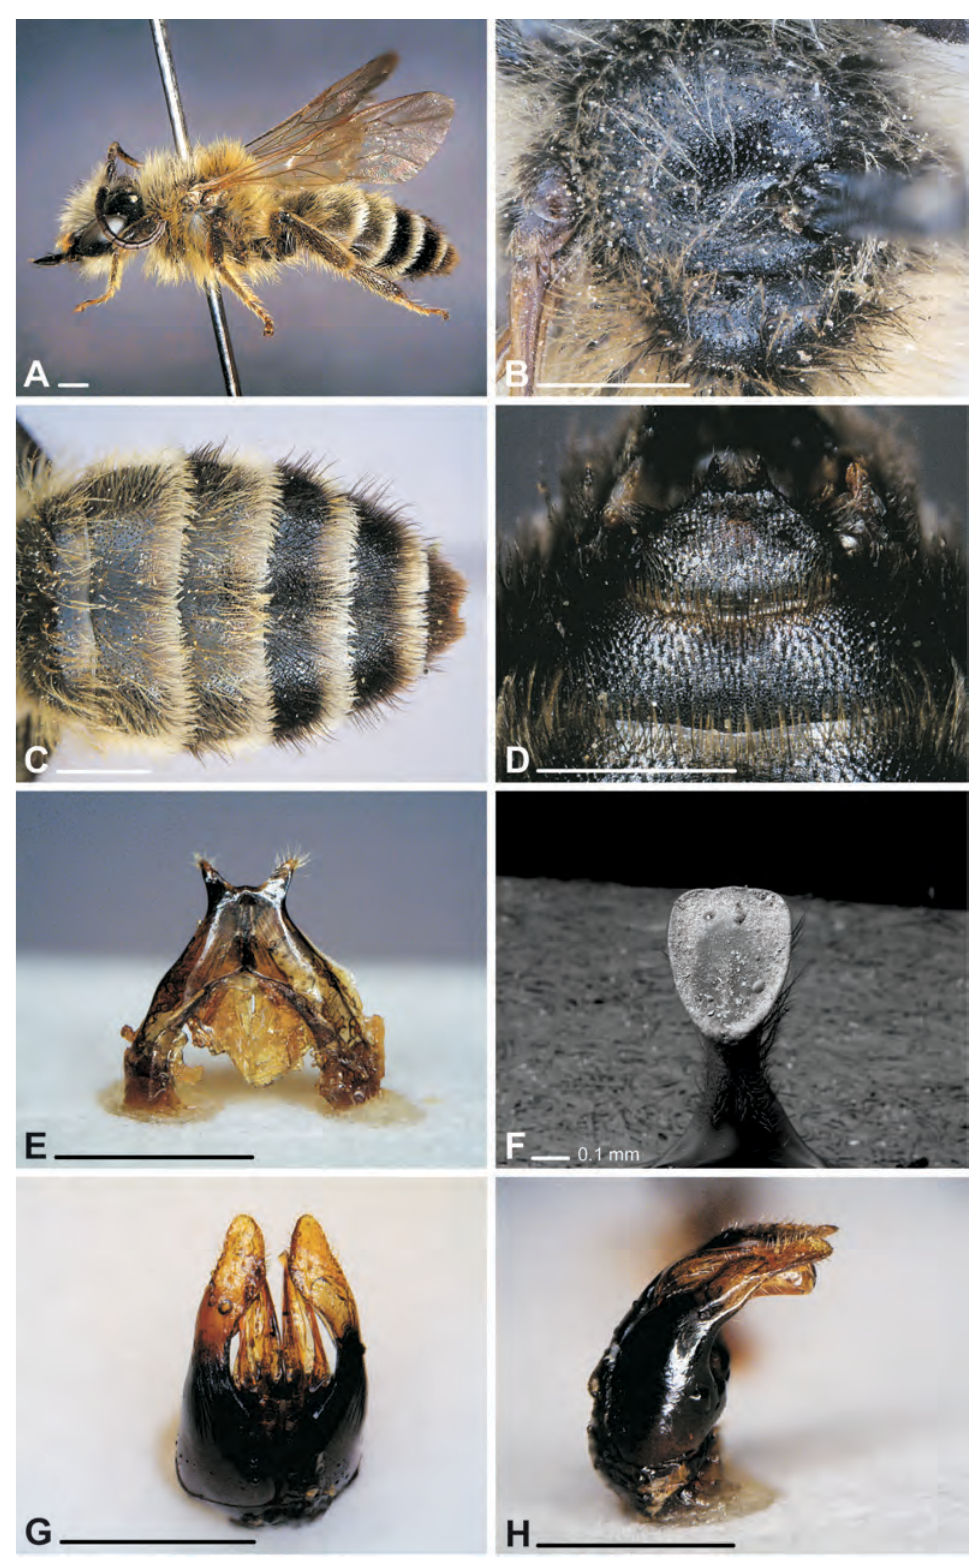
Fig. 8. Redivivoides karooensis sp. nov., ♂. A . lateral view. B . Scutum and scutellum. C . Metasoma (dorsal view). D . S6 (ventral view). E . S7 (dorsal view). F . S8, apical end (backscattered electron image). G . Genitalia (dorsal view). H . Genitalia (lateral view). Scale bar: 1